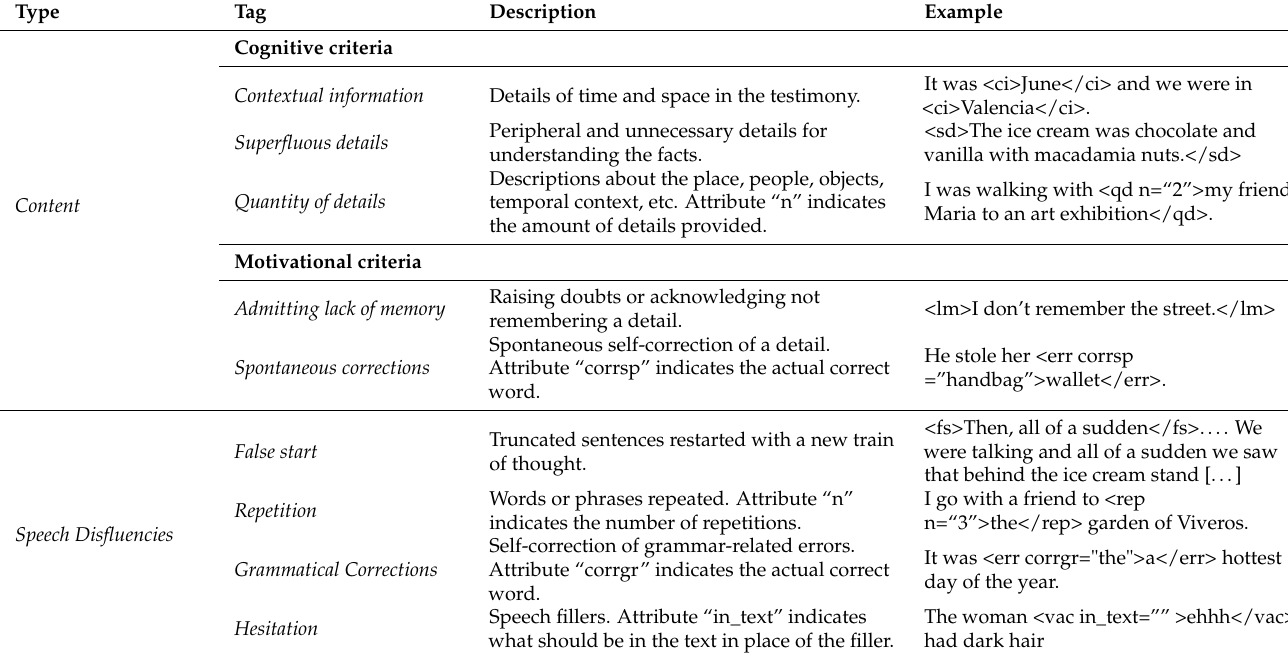
Table 2. Description and examples of the use of content and speech disfluency